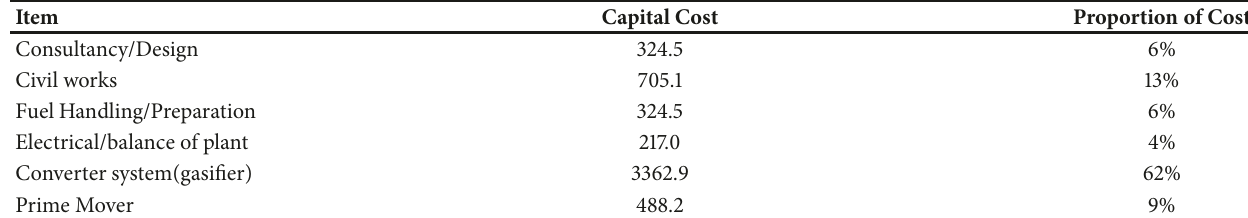
Table 12: Biomass gasification cost breakdown (2010 US $).